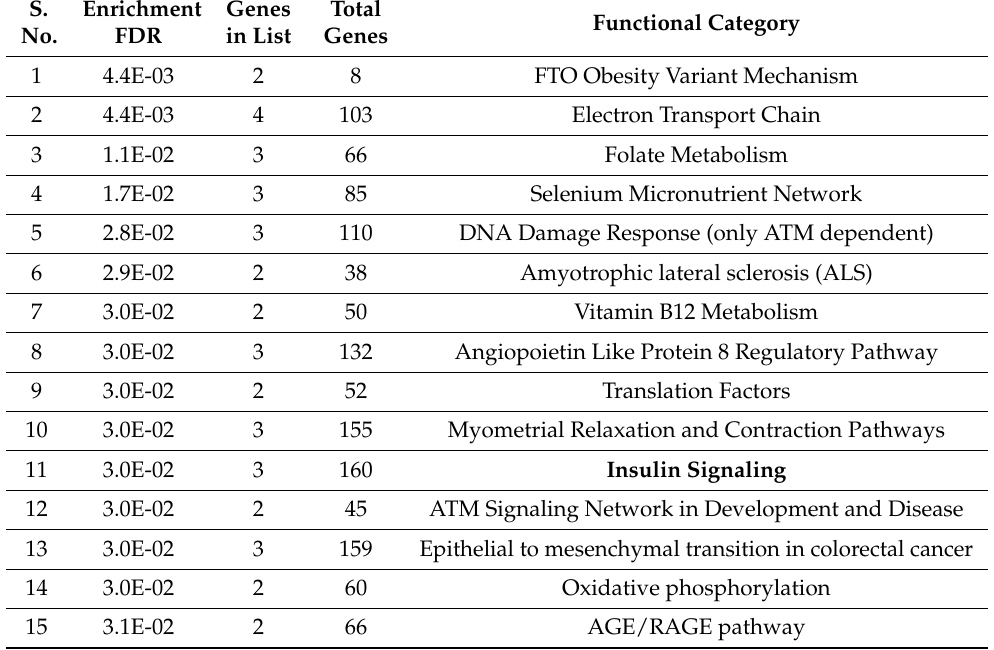
Table 2. List of pathways enriched by the IR key metagenes against the human collection of WikiPath- ways with p <